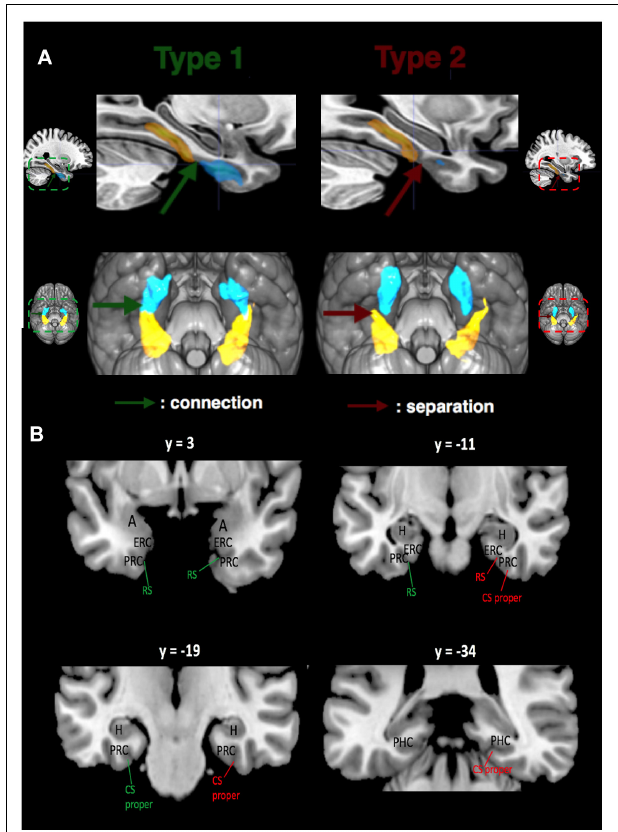
FIGURE 1 | Relations between CS proper (in yellow) and RS (in blue) for both sulcal Types shown with mean sulcal maps. (A) Left: Mean Type 1 RS and CS proper are connected (shown by green arrow). Right: Mean Type 2 RS and CS proper are separated (shown by red arrow). Mean RS and CS proper (at the population level) for Types 1 and 2 are surimposed on the MNI152 template of MRIcro. (B) Location of MTL structures. MNI coordinates are provided for the y-axis. The same color code is used: green indicates connection between RS and CS proper, while red indicates separation. Abbreviations: A, amygdala; H, hippocampus; ERC, entorhinal cortex; PRC, perirhinal cortex; PHC, parahippocampal